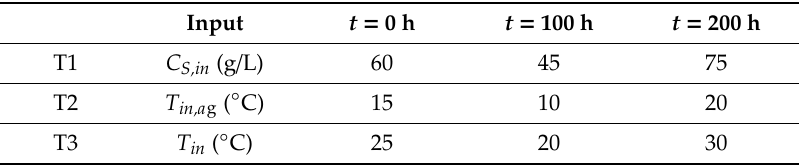
Table 4. Step changes of input